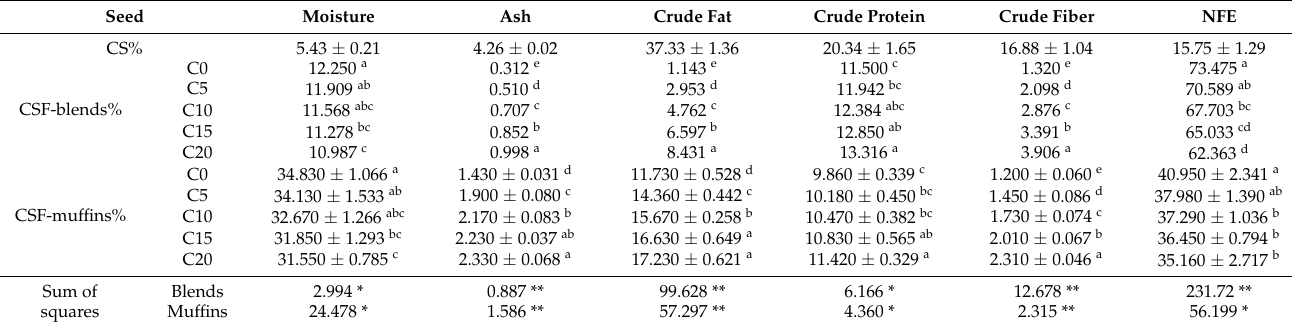
Table 3. Proximate Composition (mean ± SD) and Sum of Squares of CS, their Blends, and Muffins.